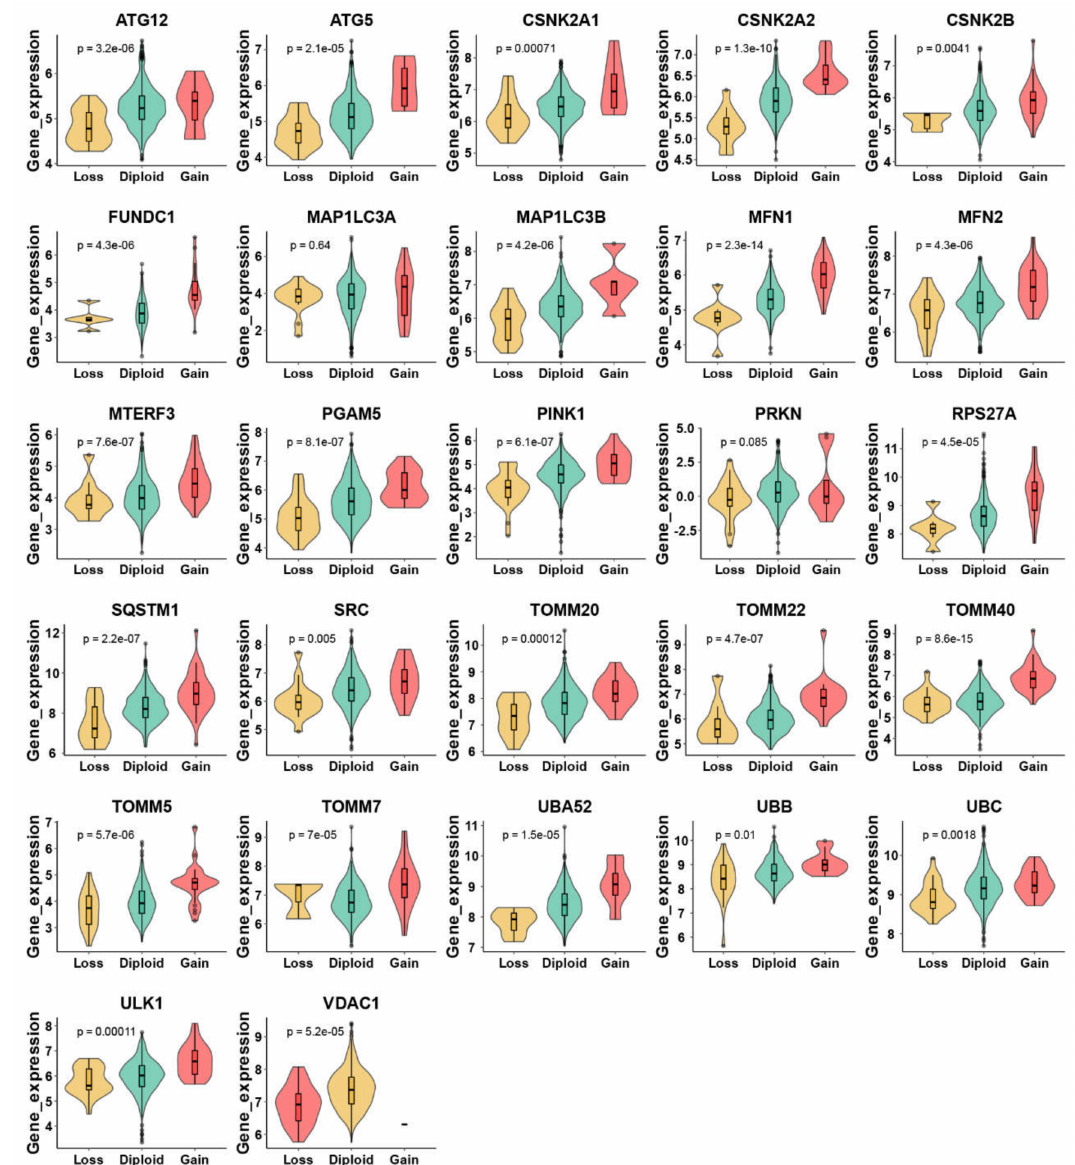
Figure 2. Relationship between CNV and mitophagy genes expression in LUAD by violin plots. The “e” in the p value represents E-notation. The E-notation is written as m En, which is equal to the scientific notation that is written as m × 10 n